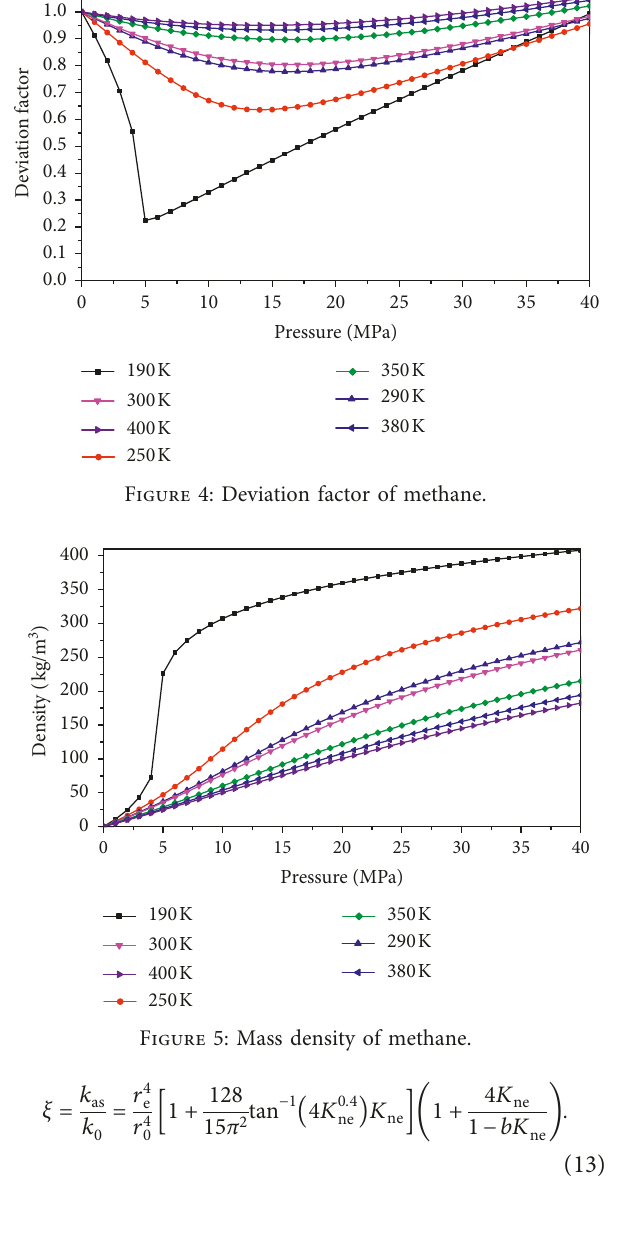
Figure 7: Knudsen number of different pore sizes and pressures ( T 400K). (cid:31)